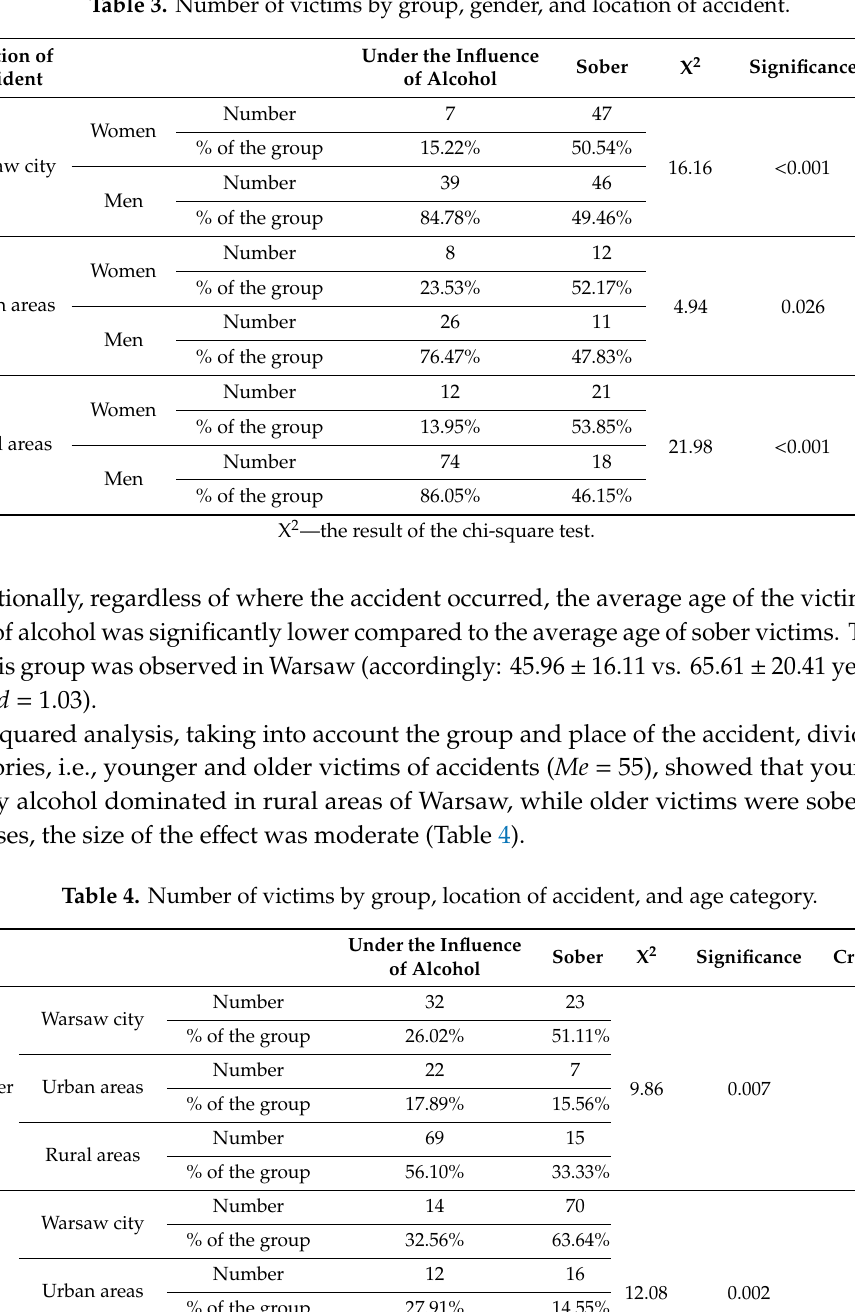
Table 3. Number of victims by group, gender, and location of accident.